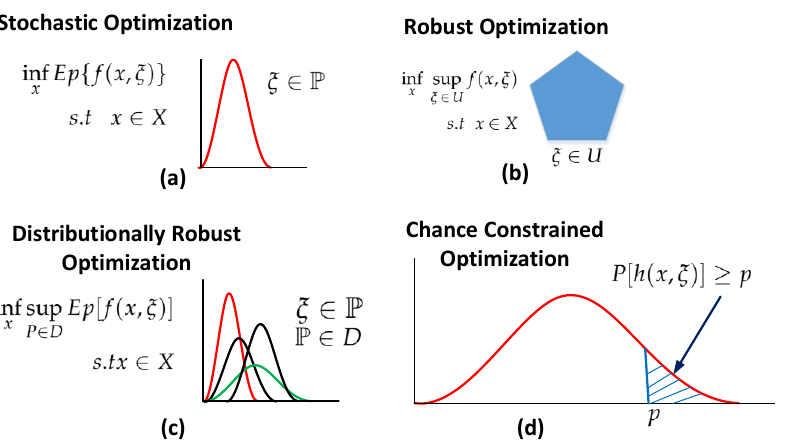
Figure 2. Graphical comparison of: ( a ) stochastic optimization; ( b ) robust optimization; ( c ) distributionally robust optimization; ( d ) chance constrained optimization.